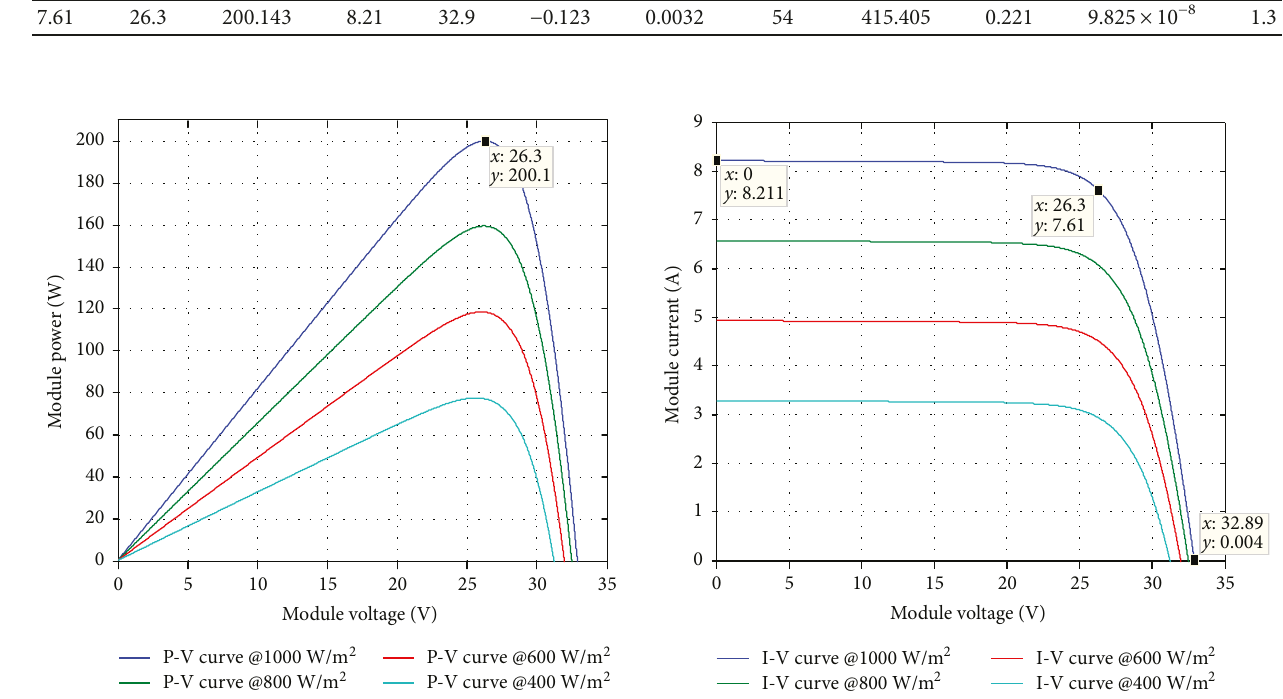
Figure 5: I-V and P-V curves of the KC200GT PV